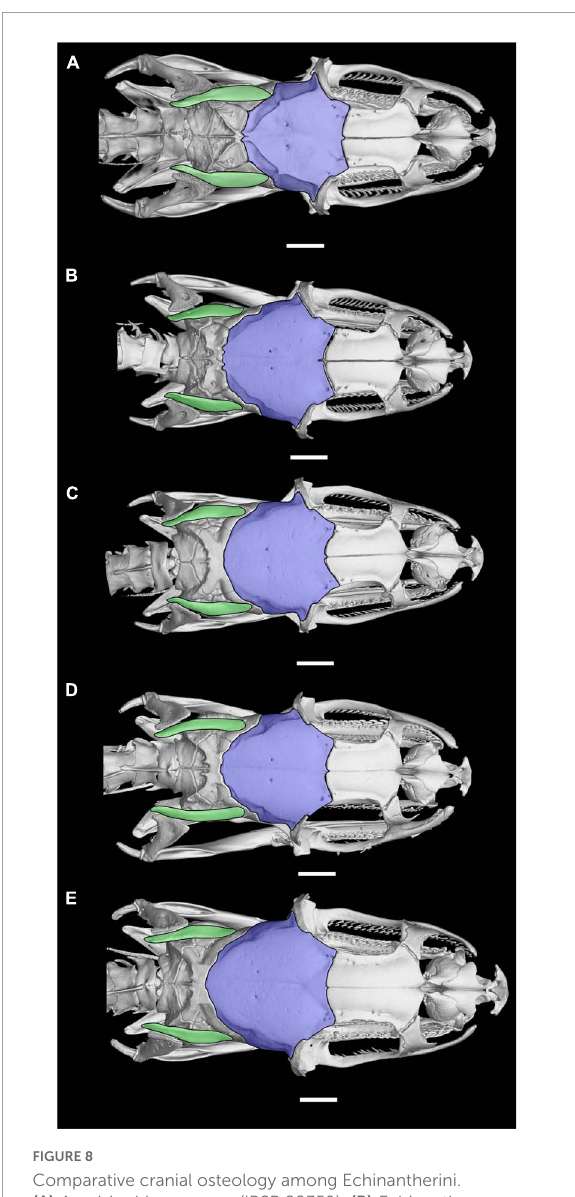
FIGURE8 Comparative cranial osteology among Echinantherini. (A) Amnisiophis amoenus (IBSP 88359); (B) Echinanthera cephalostriata , (IBSP 84971); (C) Echinanthera cyanopleura (IBSP 81751); (D) Echinanthera melanostigma (IBSP 56933); and (E) Echinanthera undulata (IBSP 22904). Colored bones: blue = parietal; green = supratemporal. Scale bars: 2 mm.